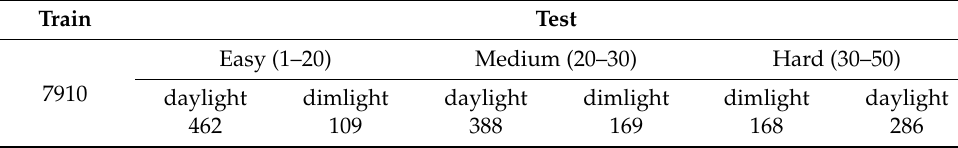
Table 1. Classroom-Face.